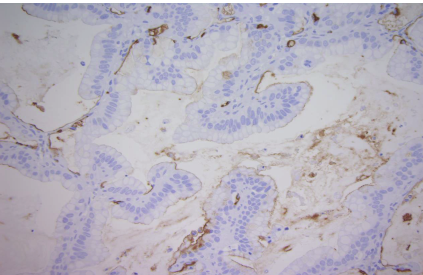
Figure 3: Anti-MUC1 staining shows a nonspecific weak partial membranous reaction in the tumor